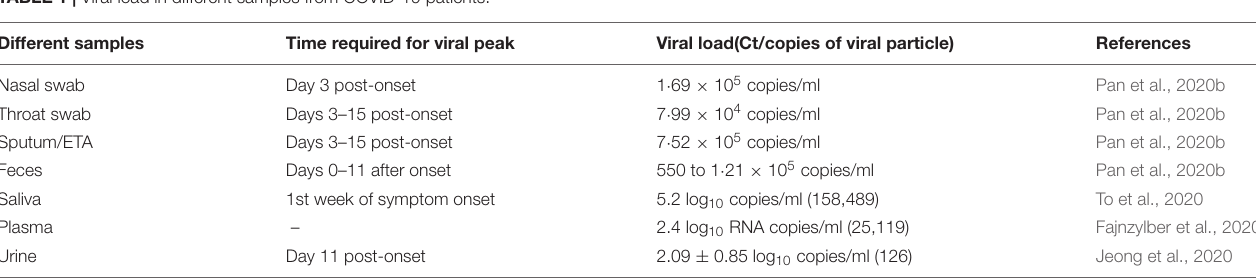
FIGURE 4 | Entry and shedding of SARS-CoV-2 into humans (A–C) , and future perspectives for molecular insights in dynamics of host response to SARS-CoV-2 [lower shaded part (D–G) ]. TABLE 1 | Viral load in different samples from COVID-19